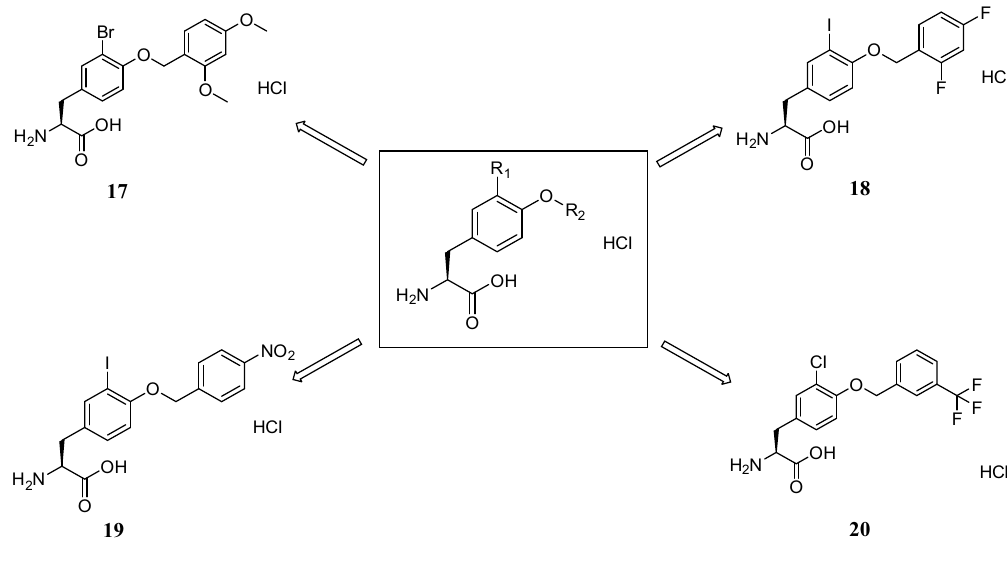
Figure 9: Chemical structures of compounds 17 – 20